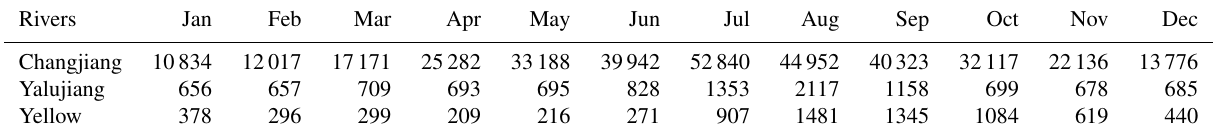
Table 1. The monthly mean river runoff (m 3 s − 1 ) of the Changjiang, Yellow, and Yalujiang rivers in the hydrodynamic model.